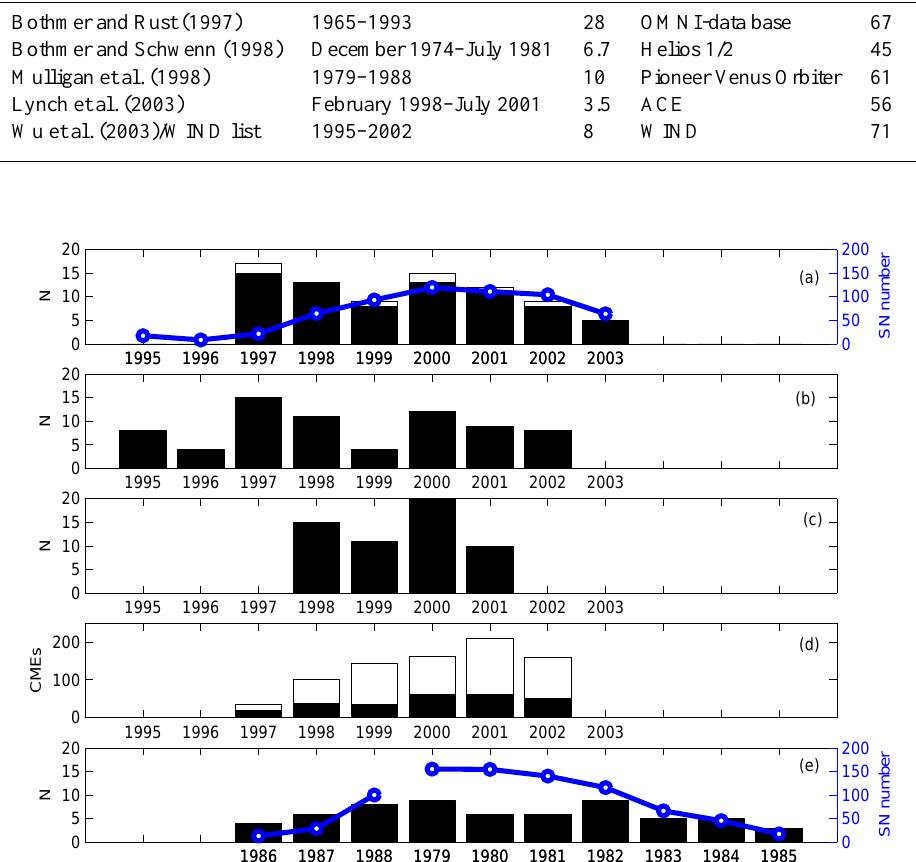
Fig. 3. Yearly number of observed MCs in our study ( a ) , in Wu et al. (2003)/WIND list ( b ) , and in Lynch et al. (2003) ( c ) , the yearly number of departed full halo CMEs (black) and partial halo CMEs (white) ( d ) , and yearly number of MCs given in Mulligan et al. (1998) ( e ) . Note that in Lynch et al. (2003) the year 2001 presents only 7 months data of (January–July). The circles show the yearly sunspot number. The white portion in bars in (a) show the number of cloud candidate events. In (e) the years have been arranged to coincide with the years of approximately the same solar cycle phase in